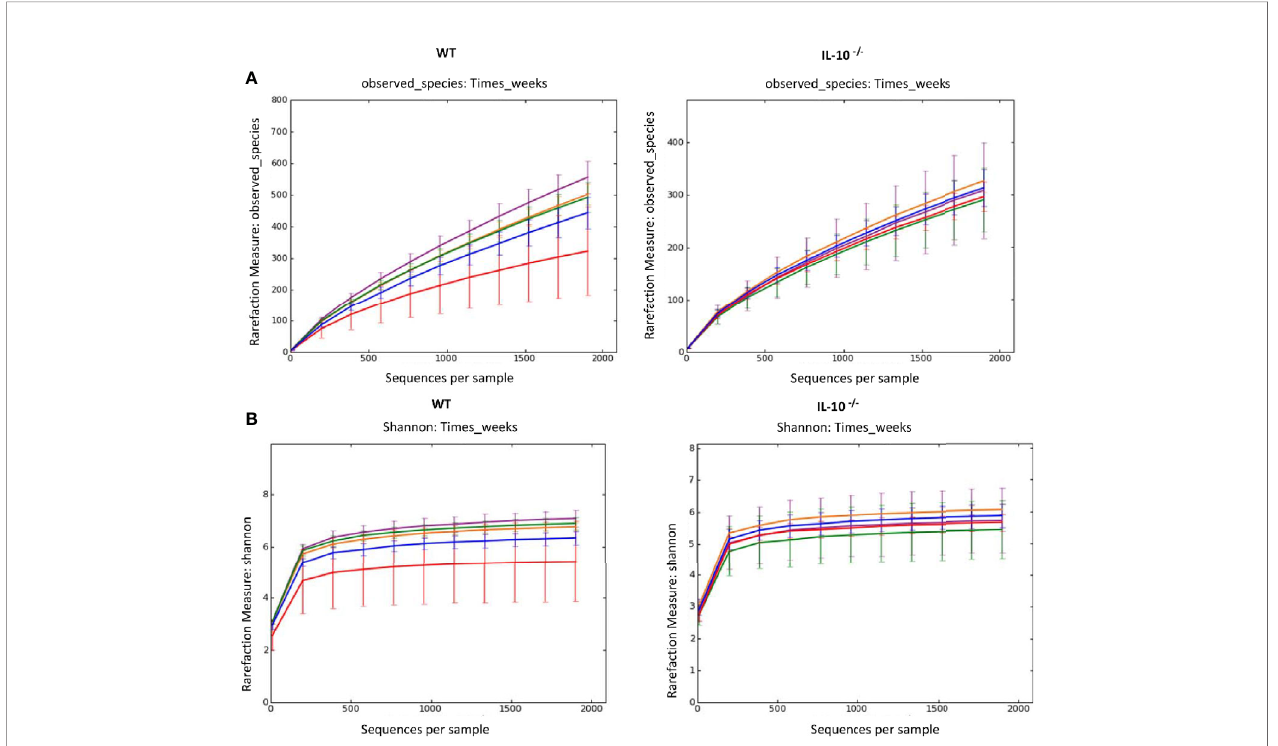
FIGURE 1 | Alpha diversity measurements of cecal microbial composition. (A) Rarefaction analysis index and (B) Shannon diversity index of 16S rRNA gene sequences obtained from cecal tissue and contents. Each line represents the average of each group from IL-10 -/- and WT mice, as indicated. Data points are as follows: red, week 4; blue, week 7; orange, week 10; green, week 12; and purple, week 19, and error bars represent the standard deviations. The number of mice used for each strain at each time point varied as follows: at 4 weeks of age, n = 5; at 7 weeks of age, n = 10; at 10 weeks of age, n = 9; at 12 weeks of age, n = 13; at 19 weeks of age, n =